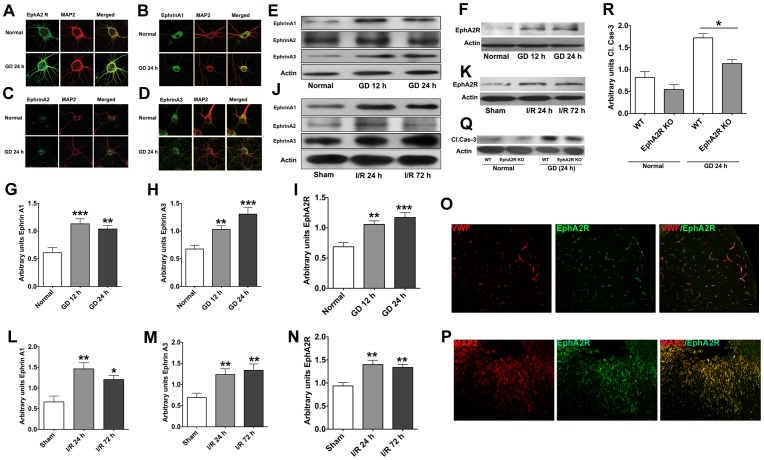
EphA2 expression is modulated following ischemic conditions in vitro and in vivo.
Wild type primary cortical neurons were used to show expression profiles of EphA2 and its ligands - Ephrins A1, 2 and 3 - using immunocytochemistry. (A–D) Cortical neurons showed expression of EphA2 and Ephrins A1–3 under normal and GD conditions. The neuronal protein lysates obtained from normal and GD conditions were probed for changes in the above-mentioned proteins using immunoblotting. (E–I) Expression of EphA2 and its ligands ephrin-A1, ephrin-A2, and ephrin-A3, was increased following GD for 12–24 h when compared to normal conditions. (J–N) A similar increase in expression was observed in vivo following cerebral I/R when compared to sham conditions. Cell-specific expression profile of EphA2 in the ischemic (24 I/R) brain sections was analysed in peri-infarct regions (200X) (O–P). EphA2 was primarily localized to neurons and blood vessels in the peri-infarct regions. Protein lysates of cortical neuronal cultures subjected to GD for 24 h were analyzed for the apoptotic cell death marker cleaved caspase-3 (Q–R). EphA2−/− neuronal cultures showed significantly lower levels of cleaved caspase-3 when compared to wild type cultures. Data are mean ± SEM, n = 3–5. *p<0.05, **p<0.001, ***p<0.0001 relative to sham (in vivo) and normal controls (in vitro) for EphA2, Ephrin A1 or Ephrin A3 blots. Data are mean ± SEM, n = 3. *p<0.05 relative to the wild type controls in Cl.Cas3 blots.